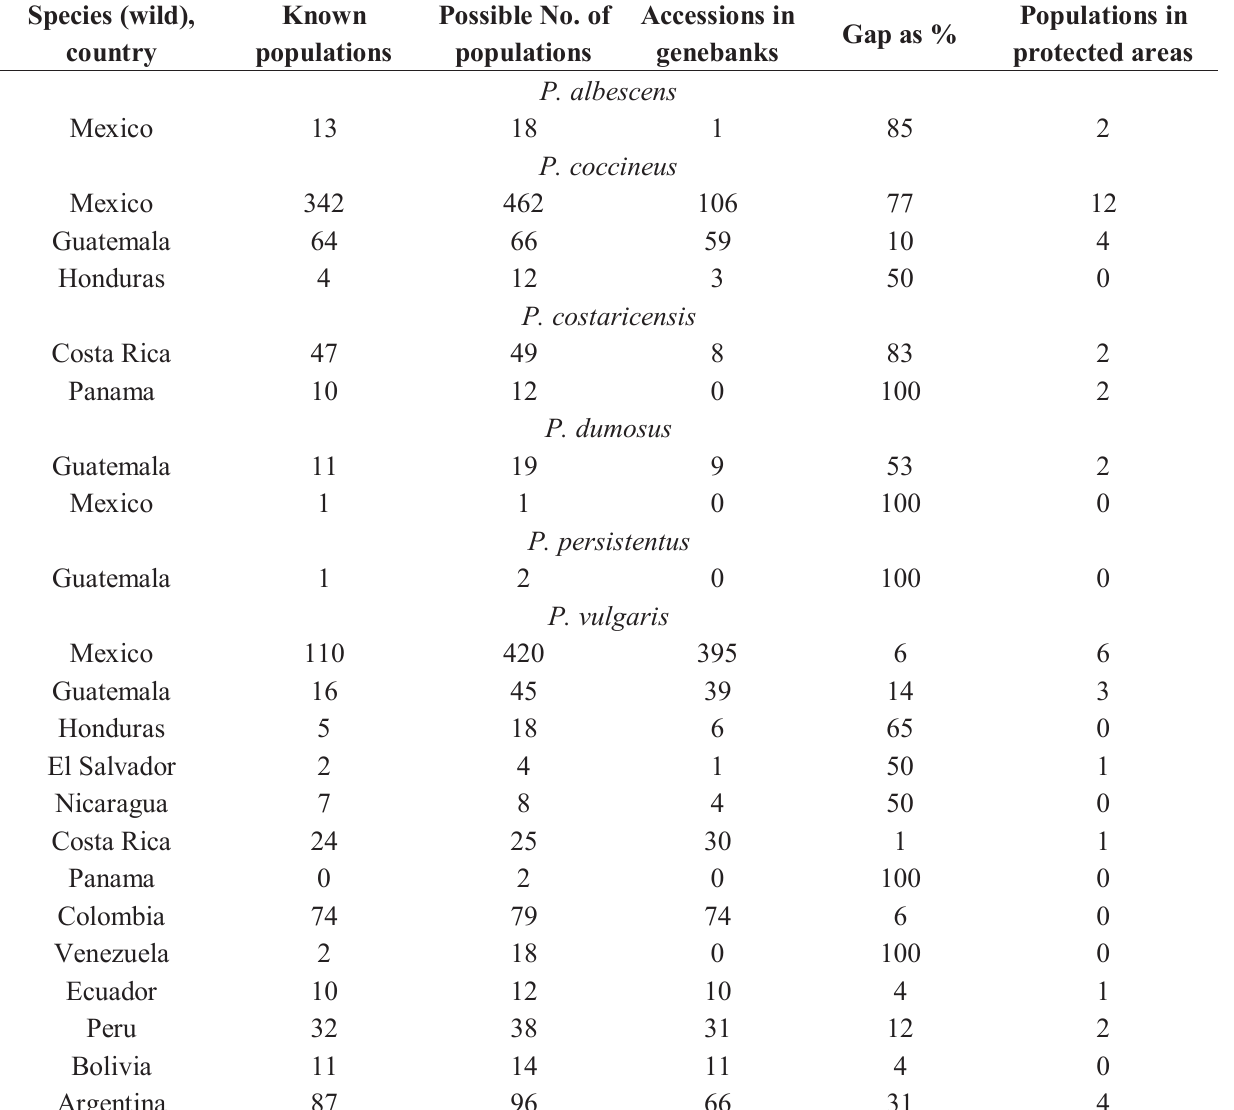
Table 2. Current conservation status for the Phaseoli section (in September